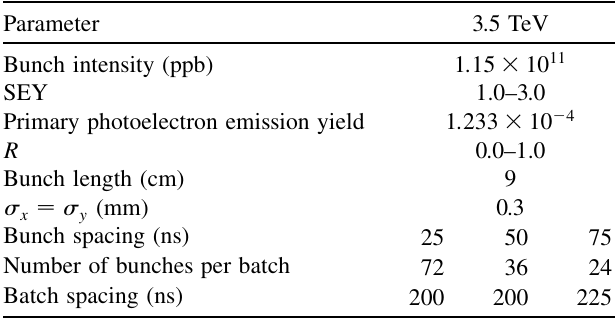
TABLE IV. Summary of simulation parameters for set D.